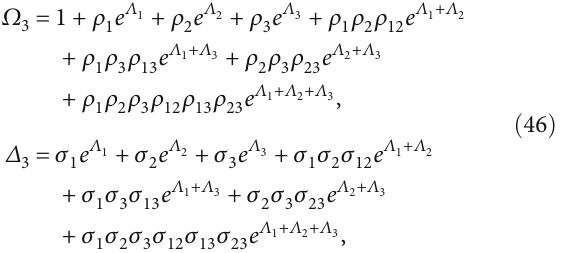
Figure 8: The two-wave solution (44) at α b ð t Þ = cos ð t Þ , y = 1, and z = 2